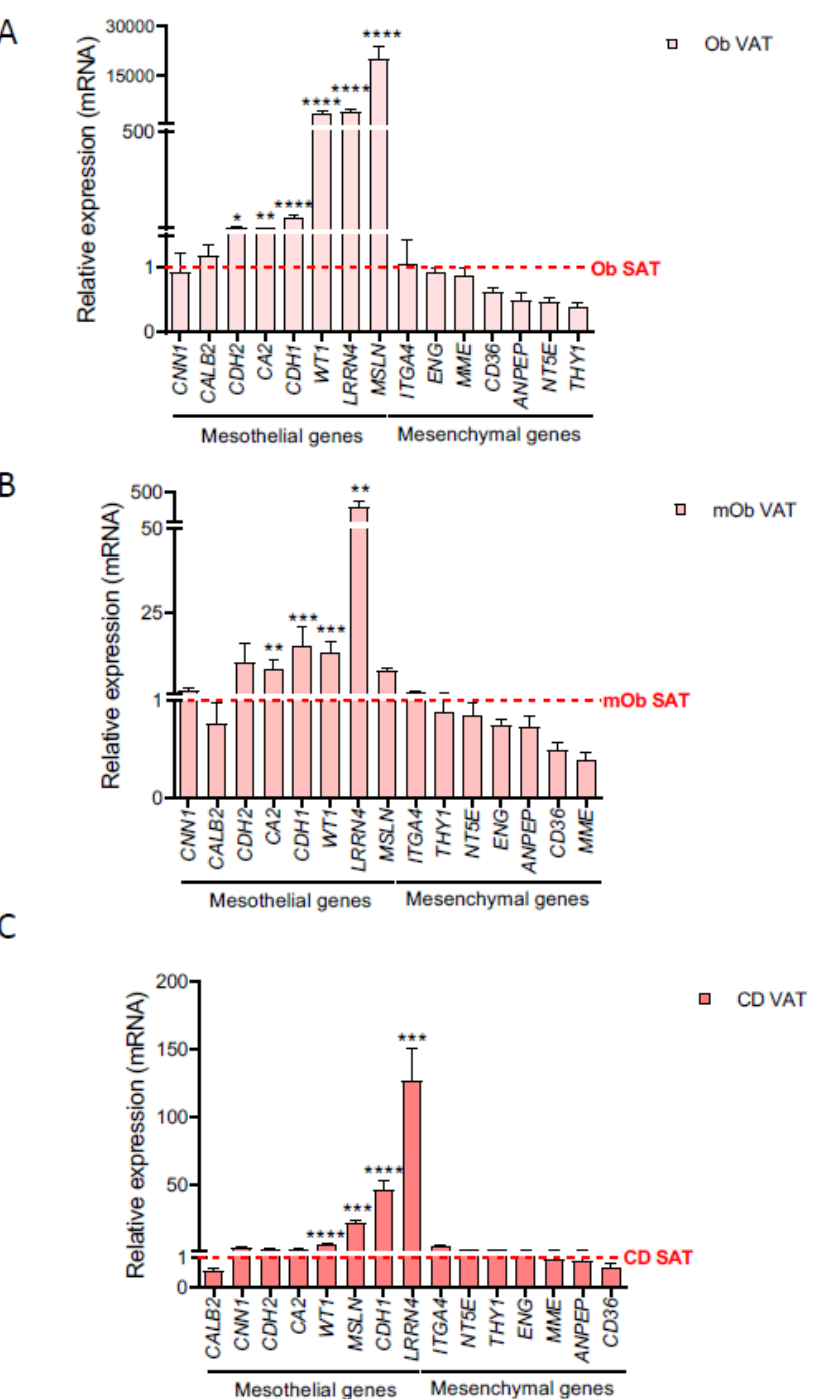
Figure 2. Mesothelial markers are upregulated in obese, morbid obese, and Crohn’s disease VAT with respect to SAT. qPCR analysis of mesothelial and mesenchymal marker gene expression in VAT versus SAT samples in ( A ) obese (ob) (ob VAT n = 10, except n = 14 for LRRN4 , MSLN , KRT8 , CDH1 , WT1 , CDH2, and CA2 ; ob SAT n = 10), ( B ) morbid obese (mob) (mob VAT n = 13 or 8, and mob SAT n = 8) and ( C ) Crohn’s disease (CD VAT n = 10, except n = 20 for LRRN4 , MSLN , KRT8 , CDH1 , WT1 , CDH2, and CA2 ; CD SAT n = 8). Mean SAT levels were normalized to 1, and are represented as a red dotted line. Abbreviations: CA2 , carbonic anhydrase 2; CALB2 , calretinin; CD, Crohn’s disease; ob, obese; mob, morbid obese; SAT, subcutaneous adipose tissue; VAT, visceral adipose tissue. Data are expressed as mean ± SEM; * p < 0.05; ** p < 0.01; *** p < 0.001; **** p < 0.0001 (Mann-Whitney U test).